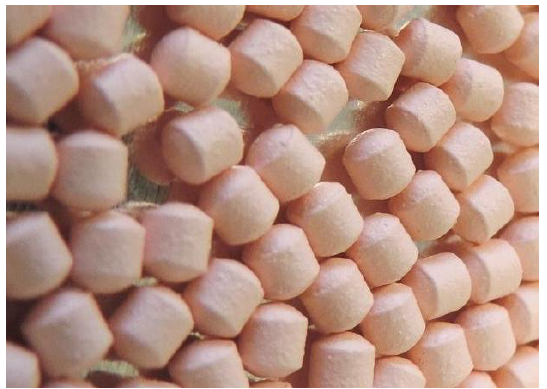
Figure 2. Coated ritonavir extrudate 2-mm particulate.